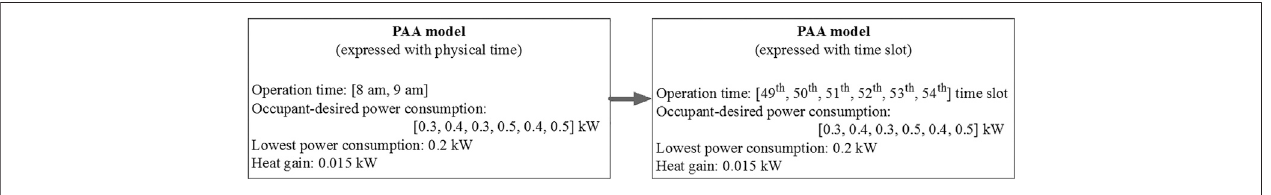
FIGURE 3 | Illustration of a PAA